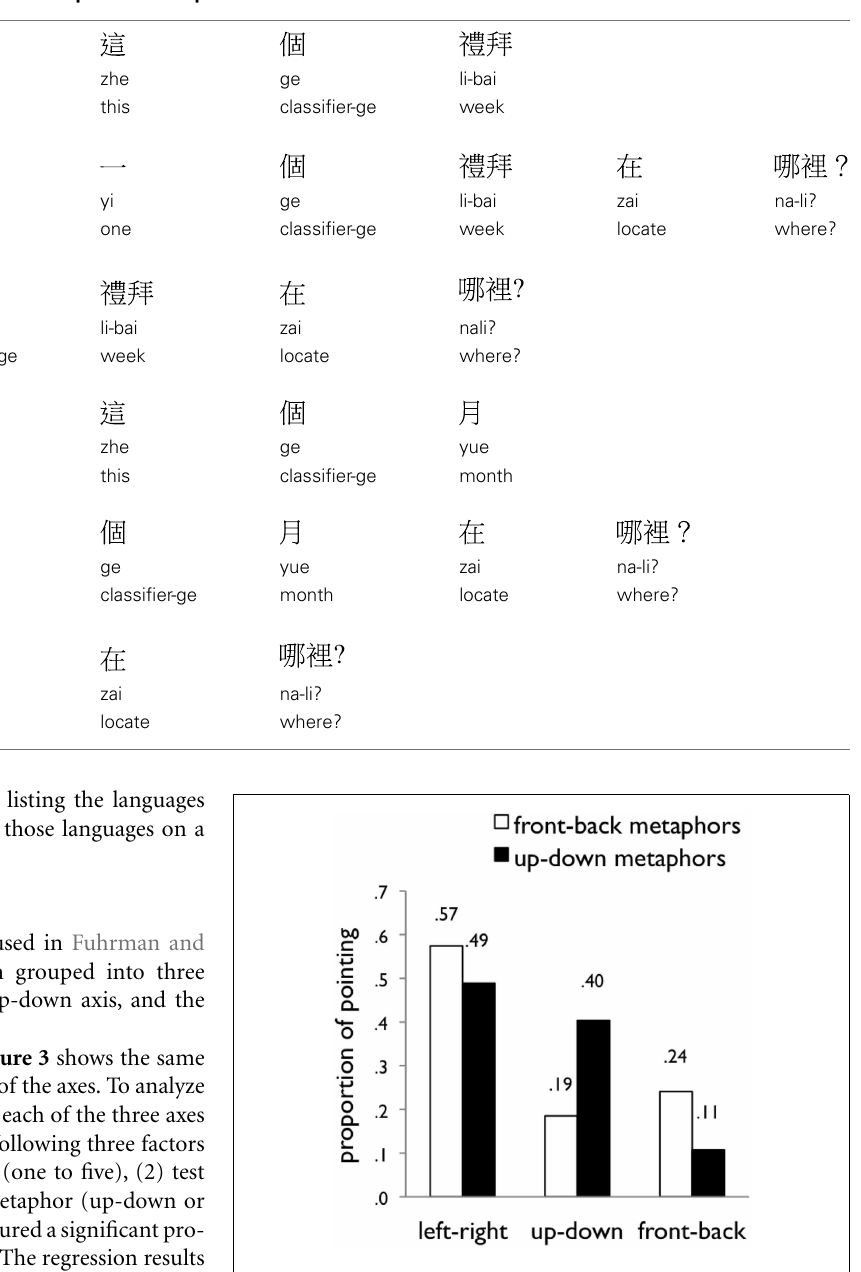
FIGURE 2 | Results of Study 2. The y -axis indicates the proportion of arrangements that fell along the three axes (left-right, up-down, front-back), depending on whether the participant was cued with front-back or up-down